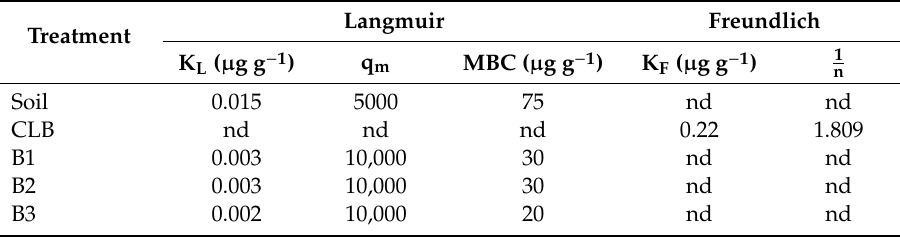
Variables from Langmuir and Freundlich isotherms for phosphorus adsorption of di ff erent